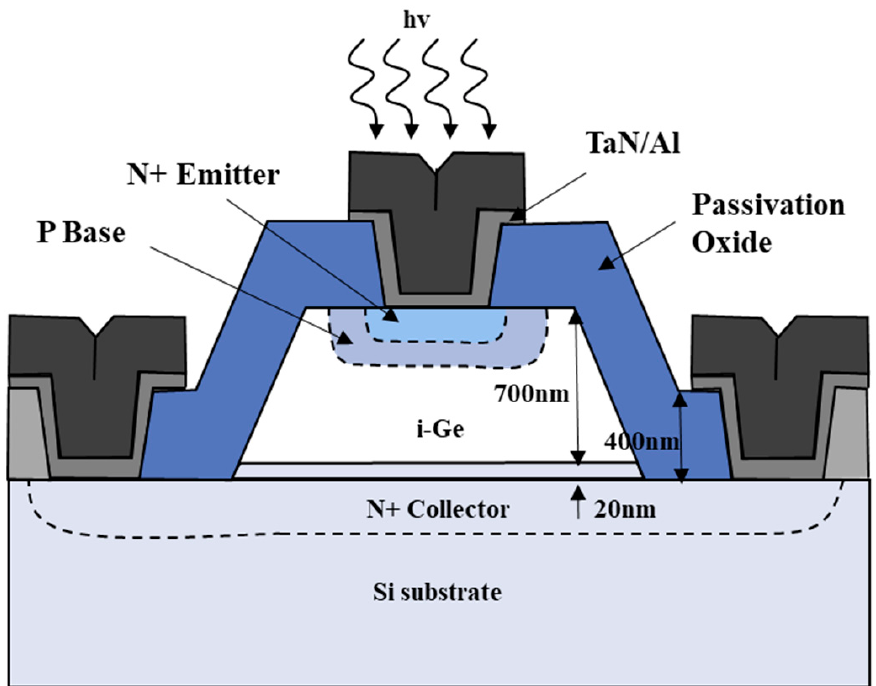
Figure 27. SEM image and schematical diagram of a Ge phototransistor. Photonic devices using group IV semiconductors on Si platforms have been of great interest for decades due to the indirect nature of the band gap of Si materials. However, there is a large lattice mismatch between the two materials, which makes the growth of Ge/GeSn on Si substrates a problem. In the last 15 years, the situation has improved dramatically with the successful growth of GeSn and the discovery of practical chemical vapor deposition (CVD) routes. The formation of high-quality GeSn films and GeSiSn alloys directly on Si substrates can be achieved. The addition of a few percent of substitutional Sn to Ge can effectively narrow the direct band gap of Ge and extend the wavelength range for absorption to more than 1550 nm. Ordinary p-i-n PDs have no internal optical gain, and APDs with internal optical gain have the disadvantages of high operating voltage and high noise. GeSn phototransistors (PTs) are considered a useful alternative to normal PDs because they have internal optical gain while operating at low voltage and without excess noise. In 2015, the performance of a front-side illuminated Ge–GeSn–GeSn hetero phototransistor grown on a Si platform was demonstrated [85]. The terminal currents, current gain, optical gain, and responsivity of the HPT at 1.55 µ m were calculated. People find that the values are comparable with those in InGaAs/InP systems, and the values for GeSn-based HPTs are even higher for lower values of base doping and base width. The proposed structure can be grown on a silicon platform, which allows it to be used as a viable alternative to InGaAs-based detectors in the C and L-band for fiber optic communications (Figure